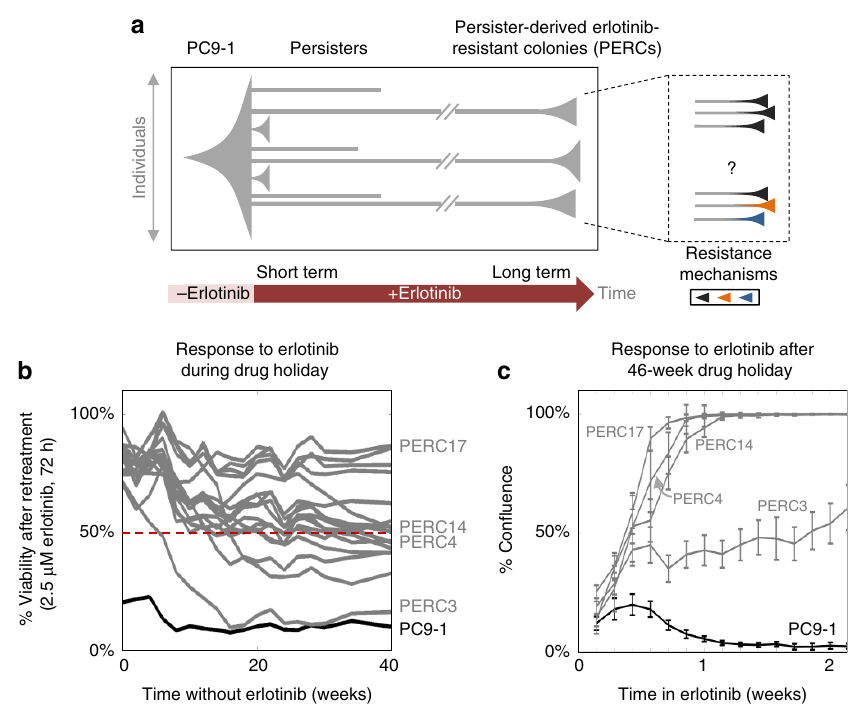
Figure 1 | The emergence of persister-derived erlotinib-resistant colonies from PC9-1 cells. ( a ) Schematic outline of the emergence of drug-resistant cancer cell populations (right), originating from a common clone (left), through the bottleneck of drug-tolerant, slow-growing persisters (middle grey lines). The vertical axis indicates population size; the horizontal axis is time. ( b ) Evolution of PERC sensitivity to erlotinib after removal from drug treatment. PERCs were grown in erlotinib-free media and periodically retested over B 40 weeks for erlotinib sensitivity (2.5 m M erlotinib, 72h CellTiter-Glo assay; Methods). Black: PC9-1; grey: PERCs. Viability values are calculated as the mean of technical replicates ( n ¼ 3 ); average s.d. between replicates is 1.23. Dotted red line marks 50% viability as compared with drug-free growth; we note that when a PERC response curve crosses this line it has an IC50 of 2.5 m M erlotinib (which is 100 times the IC50 of PC9). ( c ) Short-term regrowth of PERCs in erlotinib after drug holiday. After B 46 weeks of growth in erlotinib-free media, selected PERCs were grown in 2.5 m M erlotinib and imaged daily for 2 weeks. Growth is quantified in terms of percentage of field of view covered by cells (Methods). For each cell line, at each time point, 484 images were analysed and the mean fraction of cellular area calculated is reported here (error bars denote s.d. across the 484 images). A typical single cell covers B 0.05% of the field of view as